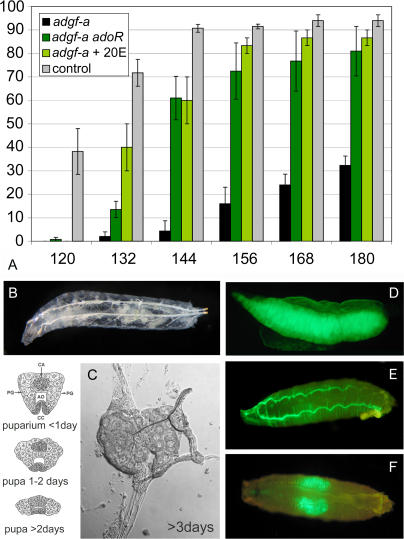
Ecdysone Regulation of Development in adgf-a
(A) Larvae of different genotypes were collected after L2/L3 molt, and the number of puparia was counted at different time points (x-axis: hours after egg laying). The y-axis shows the percentage of puparia out of all collected third-instar larvae (three vials each with 30 animals; the standard error is shown).(B and C) Ring gland morphology in arrested adgf-a larvae. Approximately 8-d old mutant larva (i.e., 3 d after normal pupariation) with very extensive fat body disintegration (note the transparency of larva in the middle part with small white pieces of fat body) (B). The ring gland dissected from this larva (C) shows morphology of the normal ring gland before the degenerative changes of prothoracic gland starts (compare to schematic diagram to the left of [C], from [28]).(D–F) Expression of GFP-marked glue protein (SgsΔ3-GFP) in salivary gland of the adgf-a mutant larvae and pupae. All late third-instar larvae express the glue protein as shown on dissected salivary gland (D). Some mutants show typical expulsion from the glands with GFP totally external to the puparial case (E), while others do not expel glue proteins even after puparium formation (F).